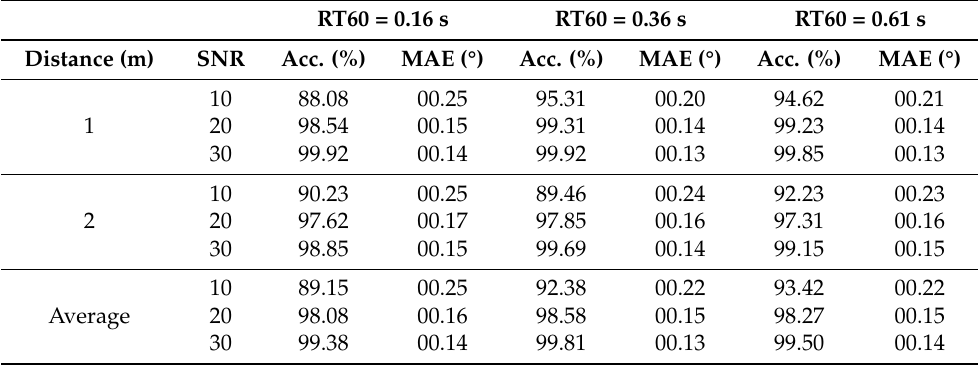
Table 9. Performance of distance estimation by CNN-R in a real acoustic environment at SNRs of 10, 20, and 30 dB,